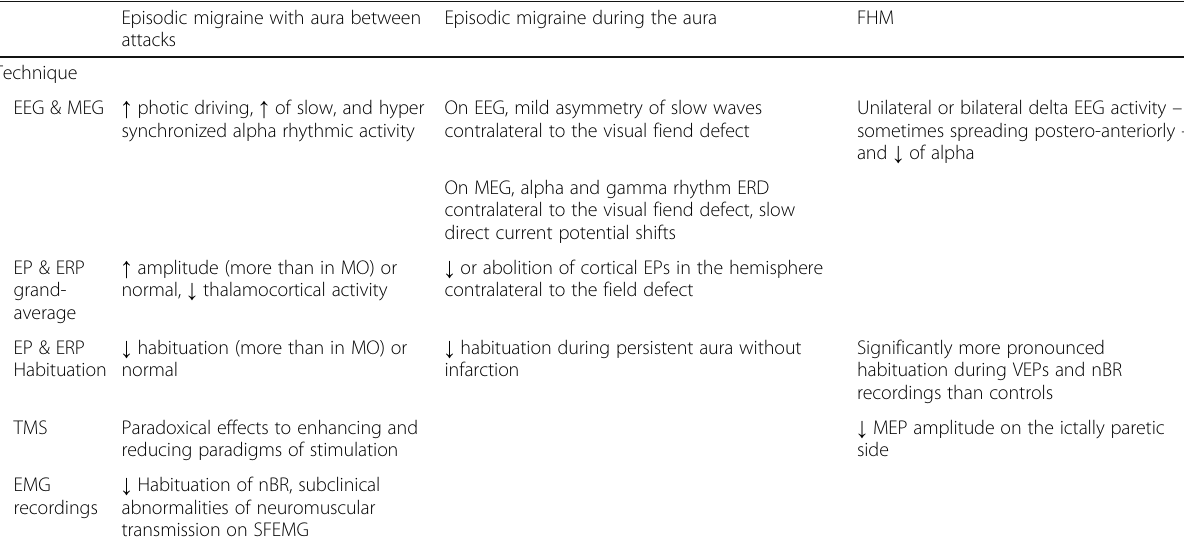
Table 1 Synoptic table of neurophysiological changes comparing episodic migraine with aura (MA) between attacks, during the aura phase, and familiar hemiplegic migraine (FHM). Arrows indicate the direction of change Episodic migraine with aura between Episodic migraine during the attacks